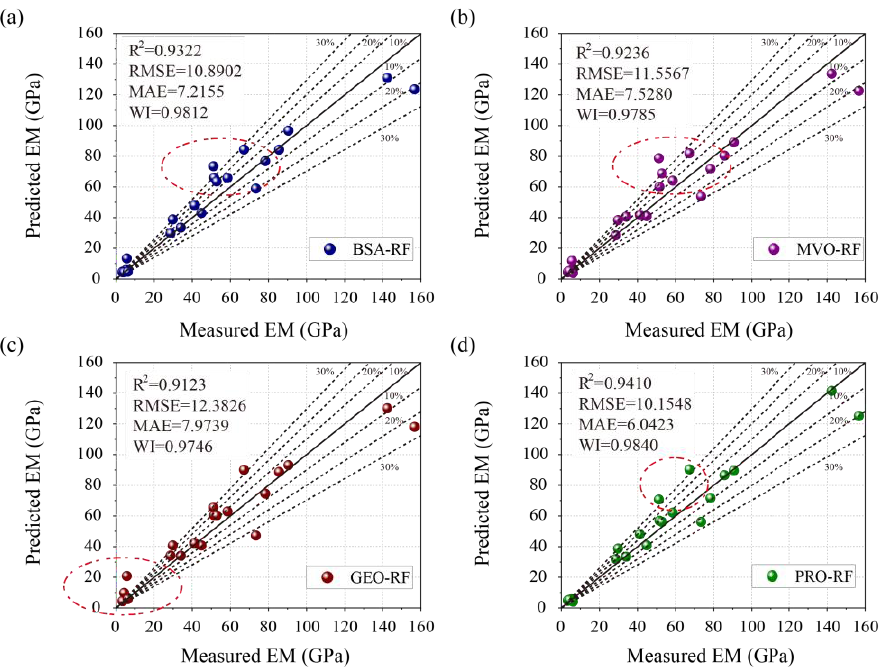
Figure 8. Regression diagrams of the four hybrid RF models using the test set: ( a ) BSA-RF model; ( b ) MVO-RF model; ( c ) GEO-RF model; ( d ) PRO-RF model.